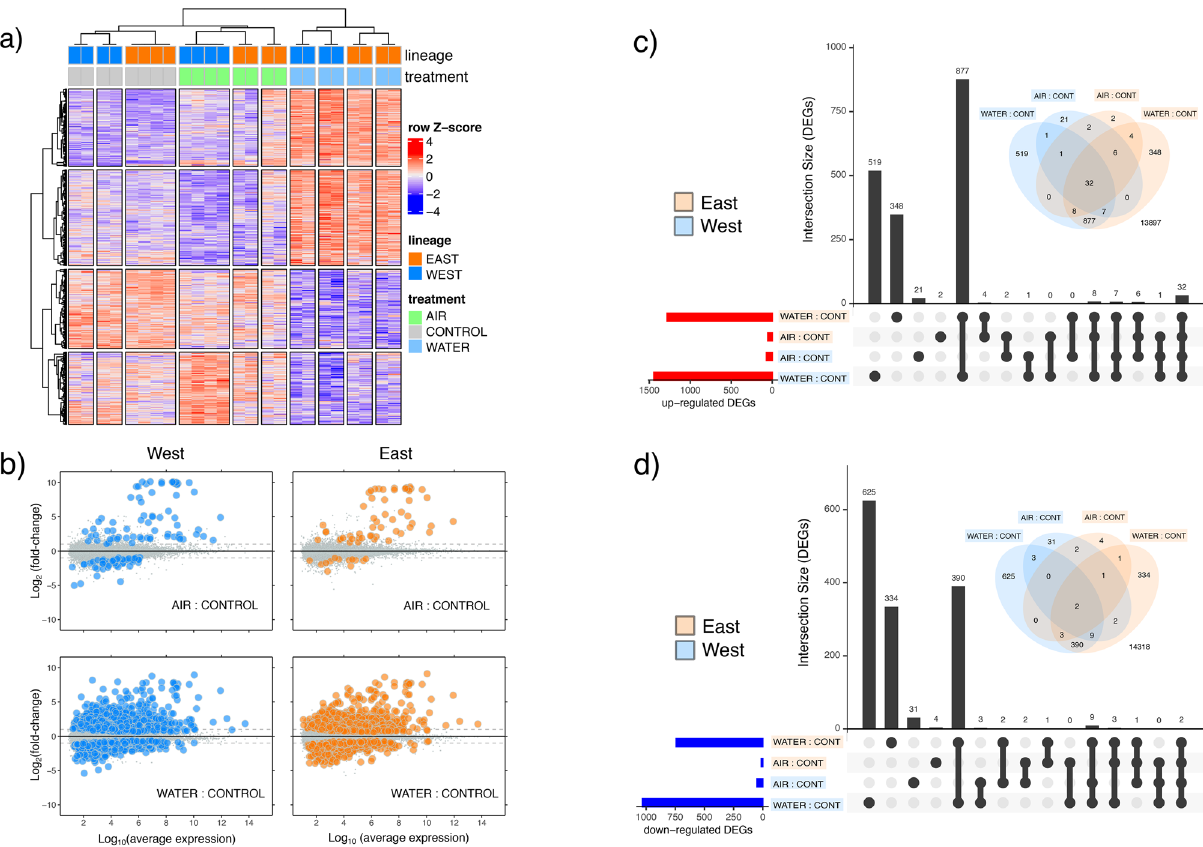
Figure 5. Differential gene expression. ( a ) Heatmap clustering of 4,567 DEGs differing between treatment within lineage or between lineages within a treatment (adj P ≤ 0.05; no fold-change cut-off). ( b ) MA plots of DEGs (coloured points; blue = West, orange = East) for AIR:CONTROL (upper plots) and WATER:CONTROL (lower plots). Intersection plots and Venn diagrams of ( c ) upregulated and ( d ) down-regulated DEGs. The intersection plots show the sizes of DEG sets for each comparison (coloured horizontal bars), and set sizes of DEGs corresponding to the Venn diagrams (vertical black bars). Heatmap was produced using R/Bioconductor package ComplexHeatMaps 42 (http:// bioco nduct or. org/ packa ges/ relea se/ bioc/ html/ Compl exHea tmap. An acylcarnitine transporter, together with genes for fatty acid beta oxidation were upregulated, as were genes for oxidative stress (Cu/Zn superoxide dismutase), inflammatory response and apoptotic signaling pathways. The increased expression of various genes involved in glycosaminoglycan (GAG) synthesis and degradation suggests that remodelling of GAGs is particularly prominent in the western lineage in response to aerial exposure, while cell division, differentiation and proliferation-related genes were among those down-regulated. Two modules showed significant correlations with WATER in the Western (“midnightblue”) and Eastern line- ages (“grey60”), respectively. The majority of genes belonging to these modules were downregulated in response to WATER (Fig. 8a,b): in the case of the Western lineage, there was a weak lineage-specific association of the module eigengene with CONTROL samples (Fig. 8a, Figs S6, S7d), which was absent in the case of the Eastern lineage (Fig. 8b, Figs. S6, S7d). The Western lineage was notable for the downregulation of several genes involved in nervous system development and function (PepP, Reelin domain, Cholecystokinin receptor), Ca 2+ regulation (PTHR1), as well as 2 cytochrome 450 family members (CYP2J, CYP2K) and lysosomal acid phosphatase (Purple acid phosphatase). The two upregulated genes were involved in oxygen-sensing and protein glycosyation (Fig. 8a). By contrast, downregulated Eastern lineage genes were mainly associated with cell adhesion and the extracel- lular matrix (FAT4 cadherins, MAM domain, collagen and chitin-binding protein), in addition to transcription factors. A dynein heavy chain (intracellular transport) was the only upregulated gene. A small set of genes represented by the “cyan” module was markedly associated with the Western lineage CONTROL samples (Fig. 8c, Figs. S6, S7e). A prostanoid receptor with potential roles in cardiovascular/immune system and possibly sensory perception, and notchless protein homolog 1 (a member of the Notch signaling pathway) were upregulated, while several genes with muscle contractile functions (Tropomyosin, Paramyosin, Twitchin) or cytoskeletal associations were downregulated.